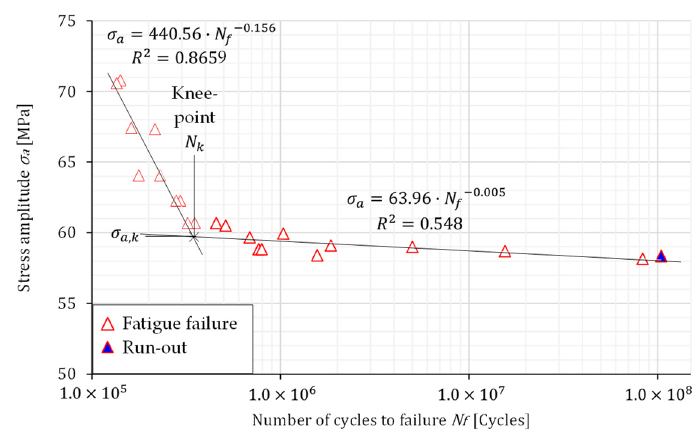
Figure 7. The S–N curve for the transverse direction. In Equations (1) and (2), the k represents the slope before the knee point, 𝜎 (cid:3028),(cid:3038) is the stress amplitude at the knee point, N k is the number of cycles at the knee point, k * is the